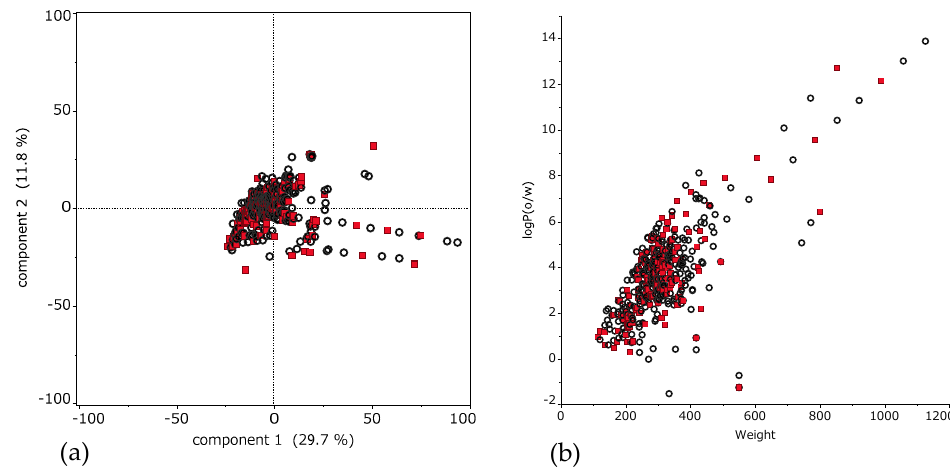
Figure 2. Chemical space of 494 compounds. ( a ) Applicability domain (AD) of 494 compounds. Scatter plot of principal component analysis using descriptors. The horizontal axis is the first principal component, and the vertical axis is the second principal component. These percentage are eigenvalue that represent a partition of the total variation in the multivariate sample. Each dot represents a compound; black circle is the training set and red square is the external validation set. ( b ) The horizontal axis is molecular weight (MW) and the vertical axis is octanol-water partitioning coefficient (logP). Here, each dot represents a compound; black is the training set and red is the external validation set.